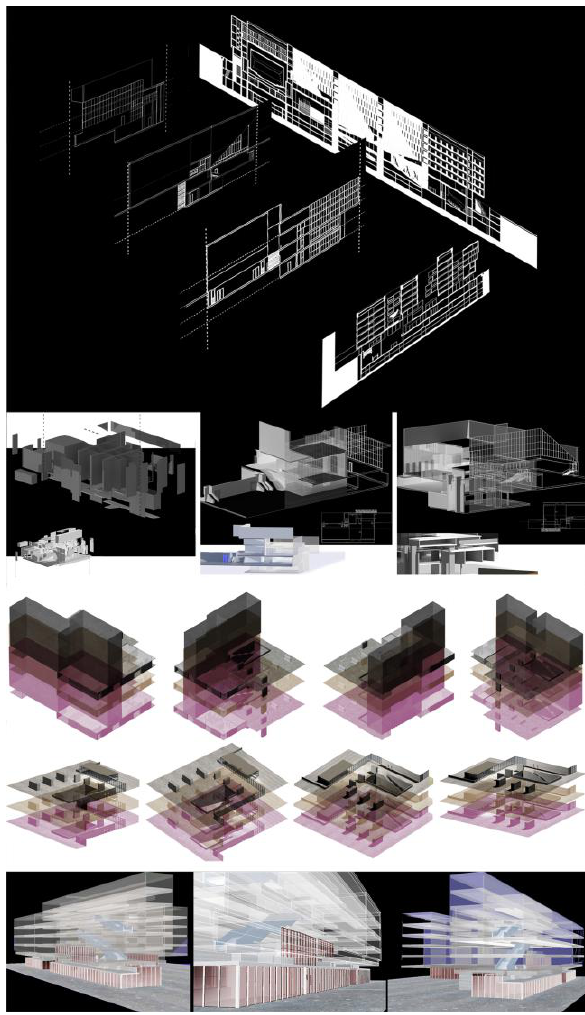
Figure 8 . New Bocconi University headquarters in Milan - Grafton building (2008). Computational Representation, Figure 10. New Bocconi University headquarters in Milan - Visual area: Evolutionary knowledge. Brera Academy of Fine Grafton building in via Röntgen (2008). Computational Arts Milan and II School of Architecture, Polytechnic of Milan Representation, Visual area: Non-Evolutionary knowledge. (A. De Masi). Brera Academy of Fine Arts Milan (A. De